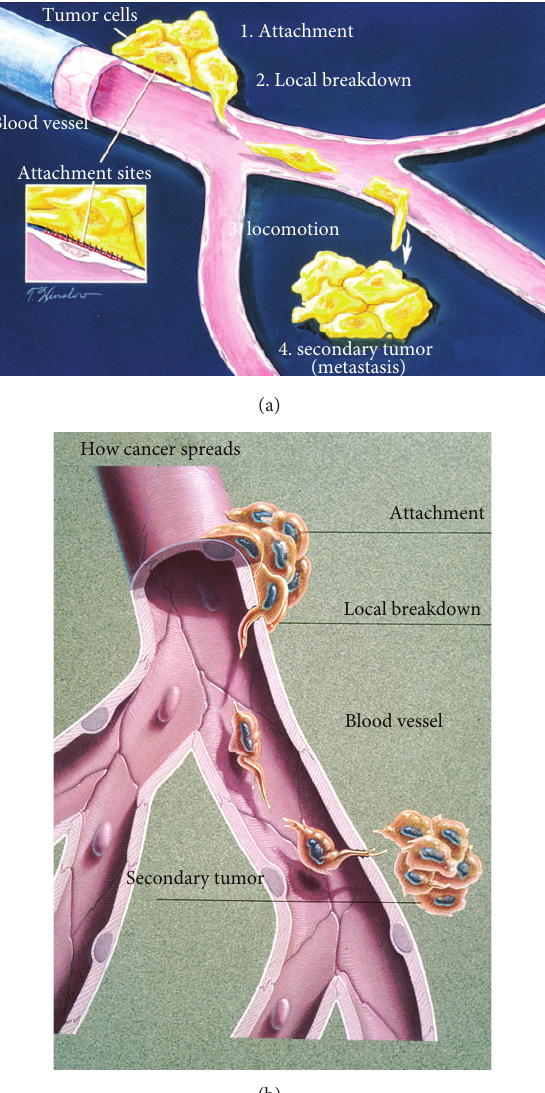
Figure 10: (a) Schematic drawing for the stages of metastasis (1) attachment (2) local breakdown with lamellipodia penetration into a blood vessel (3) locomotion with lamellipodia to exit from blood vessel (4) secondary tumor. (b) Once metastatic cells are attached to thevesselwallbasementmembrane(aphysicalbarrierthatseparates tissuecomponents),cancercanbreakthroughwithstifflamellipodia on the leading edge and the help of protease enzymes. Cancer cells then move through the blood stream enabling them to spread to other parts of the body. A secondary tumor may subsequently form at another site in the body. (With permission from the National Institutes of Health/Department of Health and Human Services).